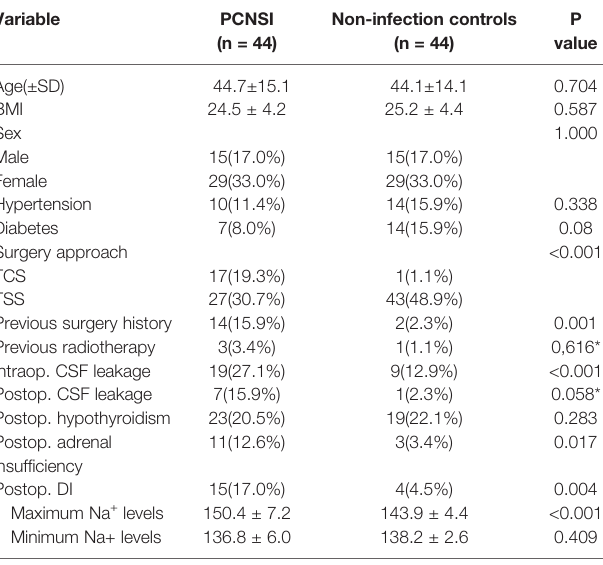
TABLE 4 | Univariate analysis of the association between each factor and postoperative central nervous system infection. Variable